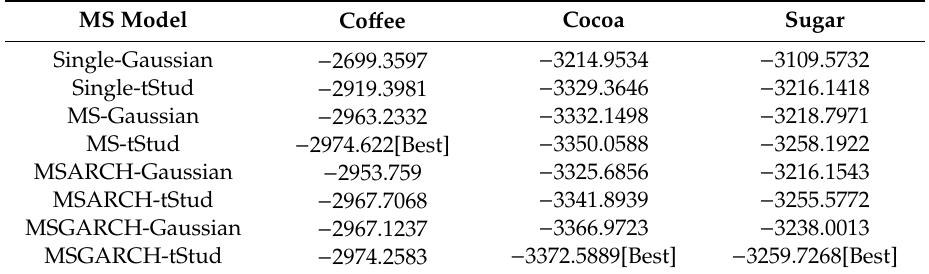
Table 2. Recursive fit test of single- and two-regime stochastic process, with di ff erent standard deviation models and di ff erent probability density function